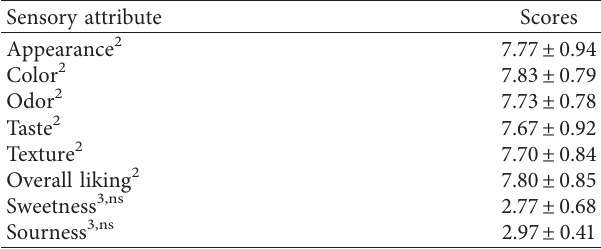
Table 2: Sensory evaluation scores of MFP jelly 1 . Sensory attribute